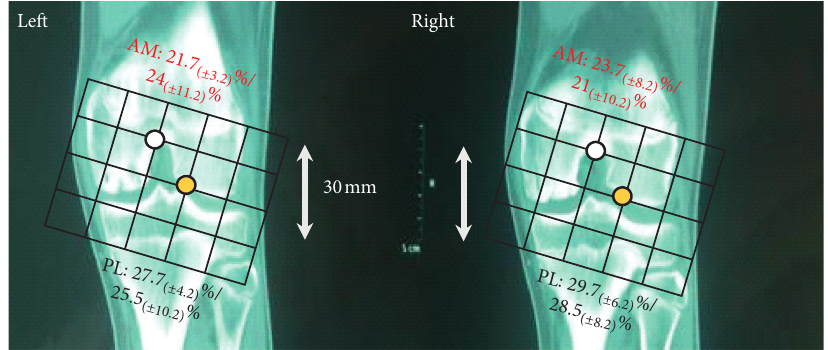
Figure 5: The ideal tibial bone tunnel positions for the left and right ACL femoral stops.